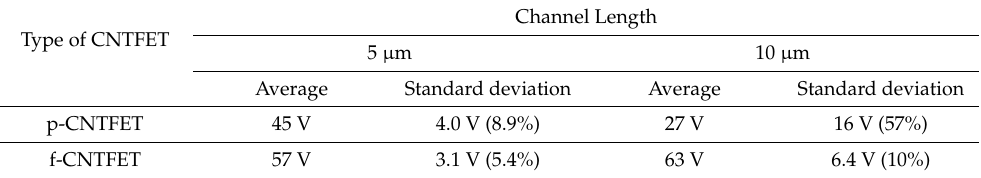
Table 2. Average and standard deviation of hysteresis of p-CNTFETs and f-CNTFETs. Only 5 µ m and 10 µ m channel devices are